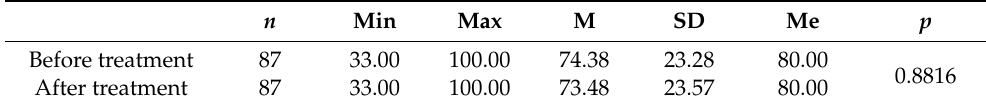
Table 4. Chemotherapy cycle versus API